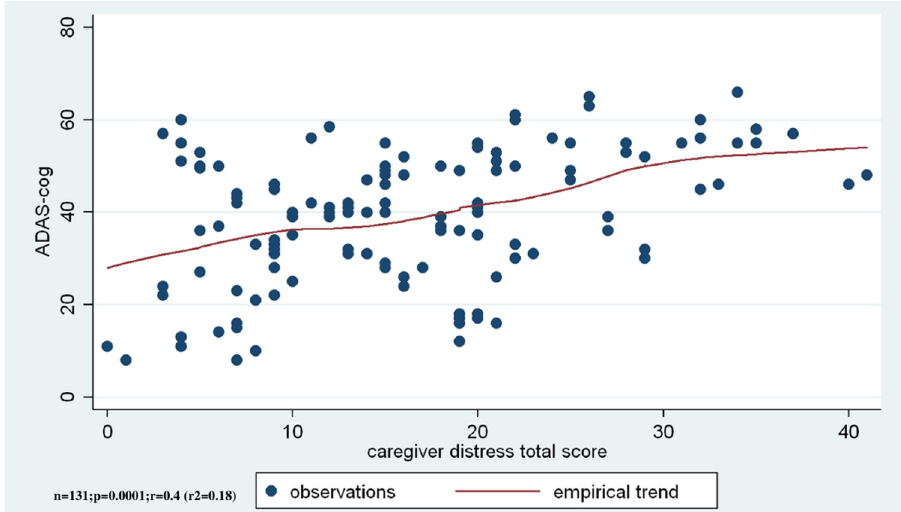
Figure 6: The impairment of cognitive functions correlate positively to the level of the caregiver ’ s